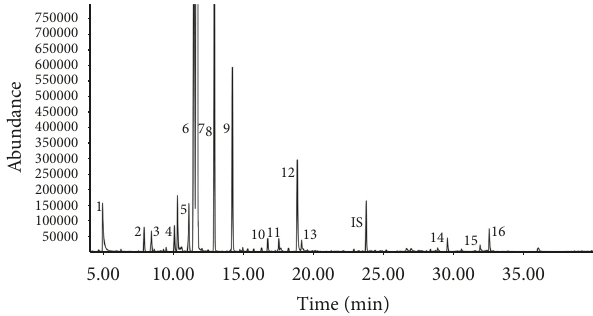
Figure 2: HS-SPME-GC-MS profile of a lemon flesh sample. Peak identification:(1)furfural,(2) 𝛼 -pinene,(3) 𝛼 -fenchene+camphene, (4) myrcene, (5) 𝛼 -terpinene, (6) p -cymene, (7) limonene, (8) 𝛾 - terpinene, (9) 𝛼 -terpinolene, (10) cis - 𝛽 -terpineol, (11) terpinen-4- ol, (12) 𝛼 -terpineol, (13) 𝛾 -terpineol, (14) trans - 𝛼 -bergamotene, (15) valencene, and (16) 𝛽